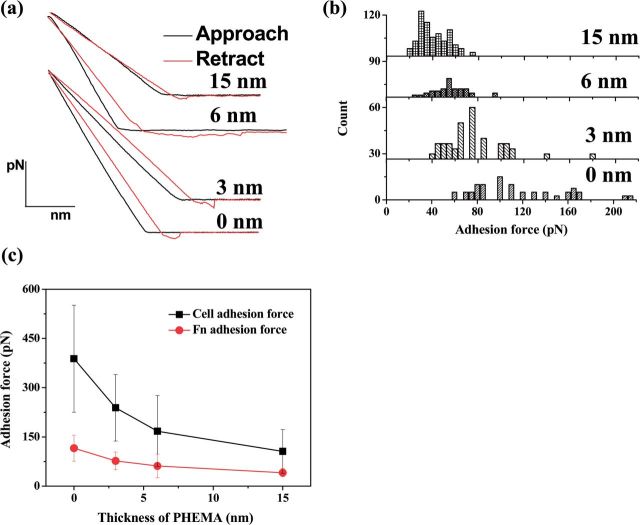
(a) Representative force-versus-distance curves between Fn-immobilized tip and PHEMA brushes with different thicknesses. (b) Histograms of adhesion force of Fn on PHEMA brushes. (c) Relationship between adhesion force of Fn and cell adhesion (data from literature [20]; the experimental details can be found thereof too) on different thickness of PHEMA brushes. The total number of Fn modified on the AFM tips remains same for all the measurement because of the same treatment of these tips.